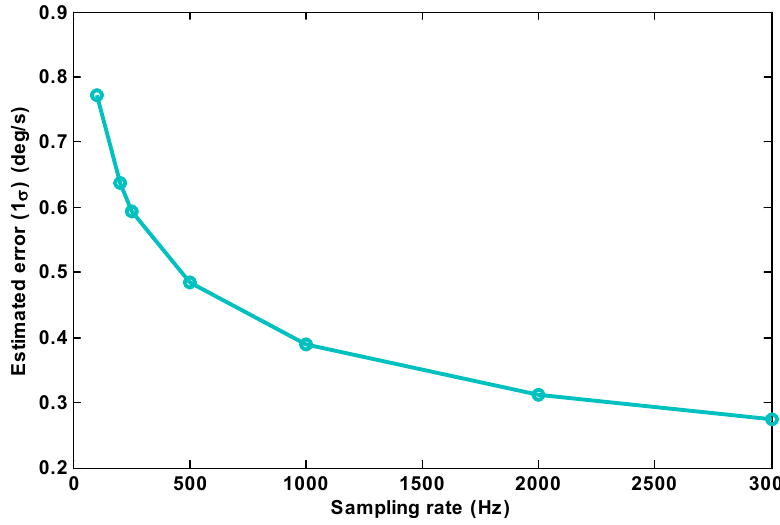
Figure 6. Plot of the 1σ estimated errors versus the sensor sampling